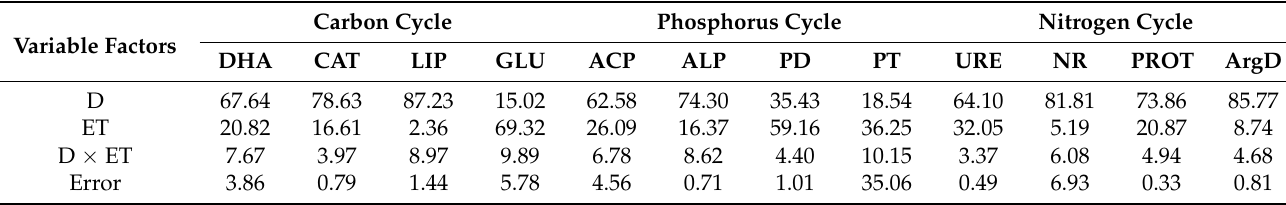
Table 3. Percentage share of factors contributing to enzyme activity in the soil exposed to tetrabutylphosphonium bromide [TBP][Br] in pot experiment with spring